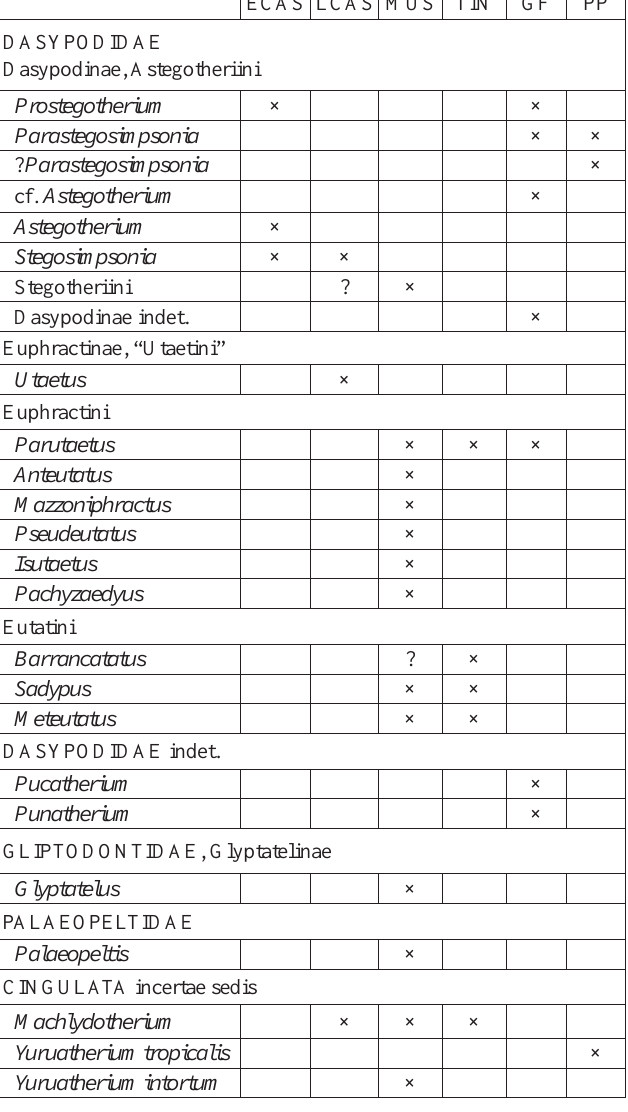
Argentina; middle member of the Geste Formation (sensu Alonso 1992); middle–late Eocene.